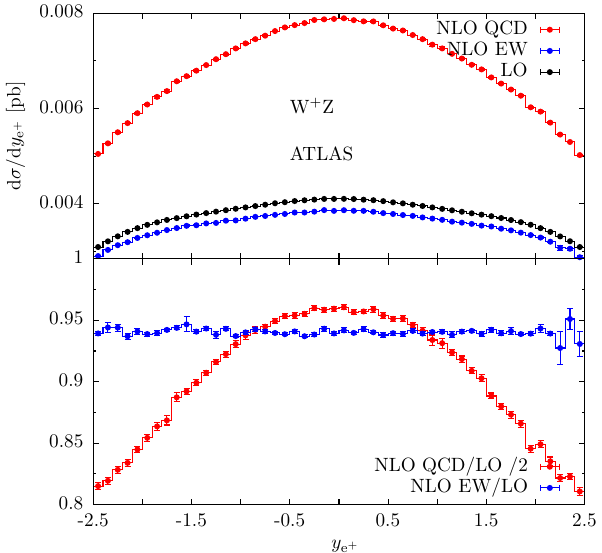
that the NLO QCD predictions have been divided by a factor 2 in the ratio NLOQCD / LO. Same notations and conventions as in Fig.